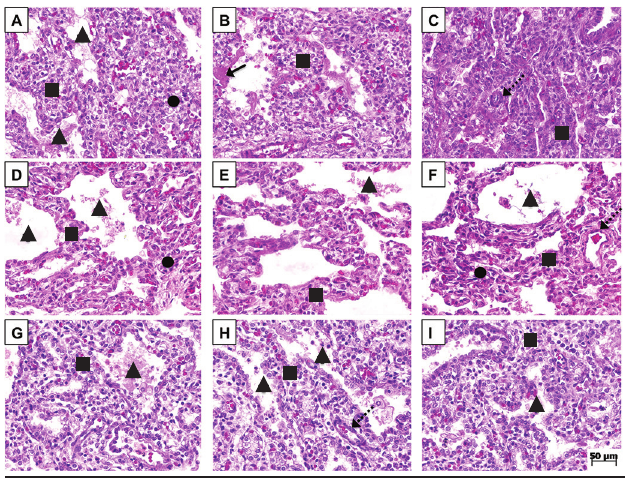
FigurE − Photomicrograph of